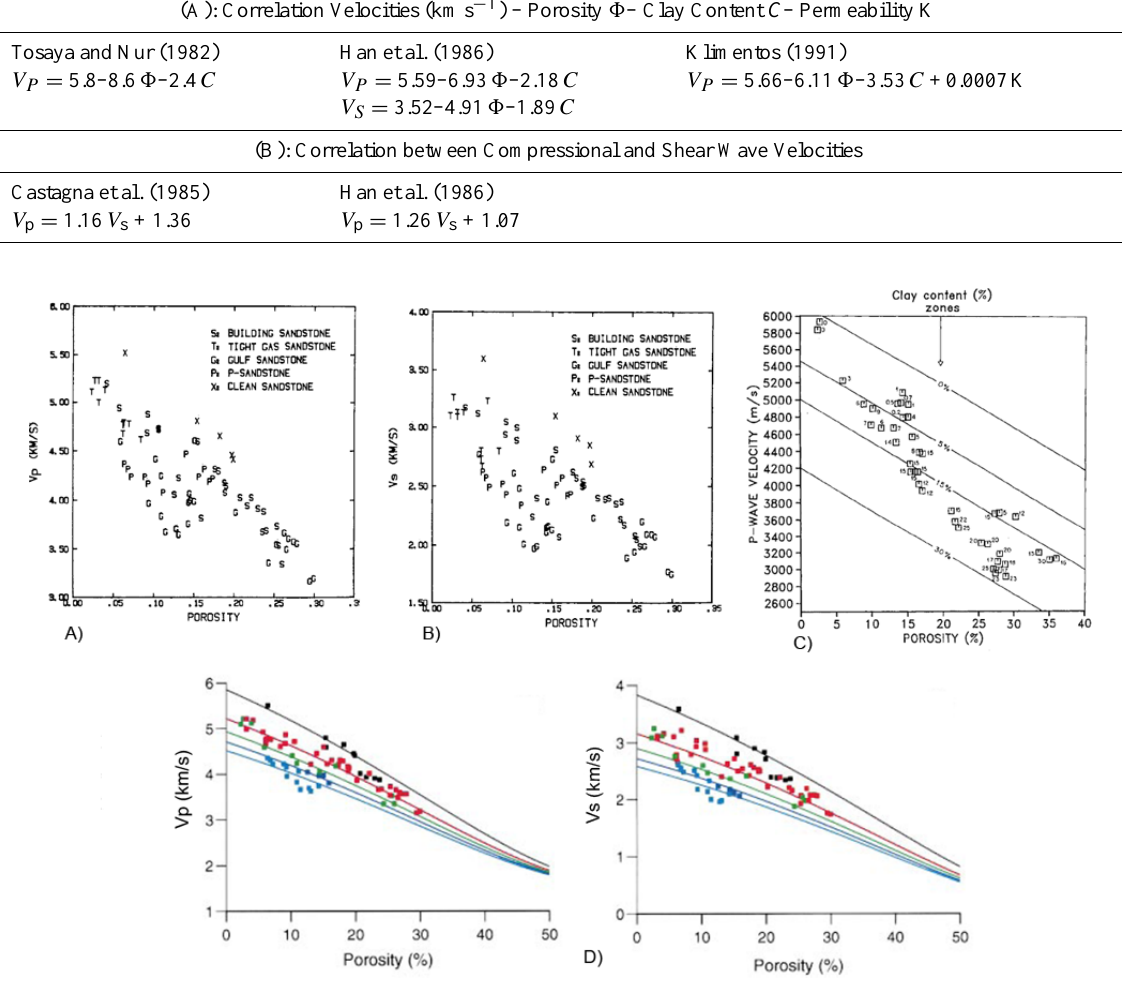
Fig. 2. Plots summarizing some literature studies on seismic velocities versus porosity. Modified after Han et al. (1986) (plots A–B ), Kli- mentos (1991) (plot C ) and Carcione et al. (2000) (plot D